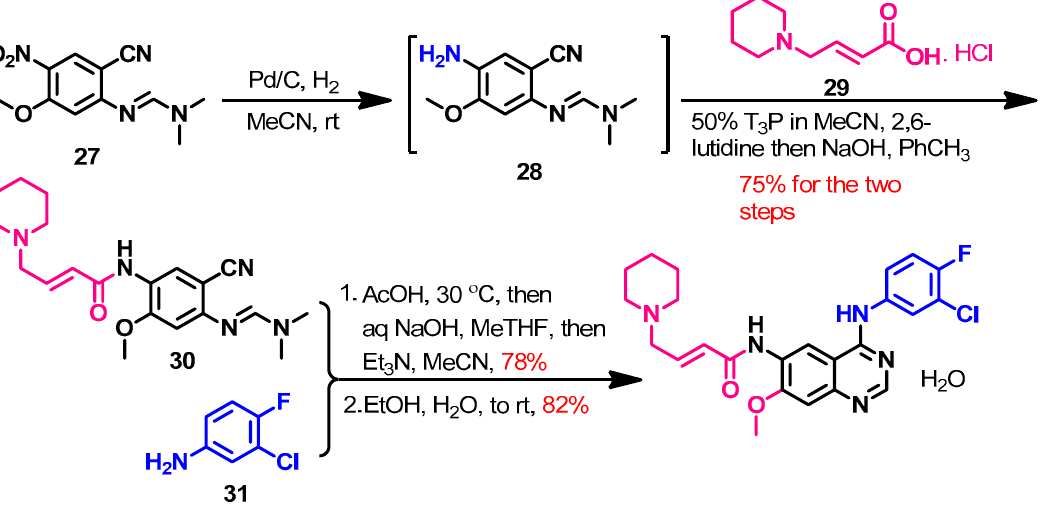
Figure 22. Kinase inhibitory activities of dacomitinib. Crystal Structures and Binding Interactions Dacomitinib exists in two crystal structures in the protein data bank. These crystals include dacomitinib in complex with the wild-type EGFR kinase domain (pdb: 4I23) and T790M EGFR kinase domain (pdb: 4I24) [66]. The binding mode and interactions of dacomitinib into EGFR T790M kinase domain (pdb: 4I24) are visualized in Figure 23. Dacomitinib exhibited one covalent bond with Cys797, one conventional hydrogen bond with Met793, one halogen interaction with Leu788, one pi-donor hydrogen bond with Thr854, and three carbon hydrogen bonds with Gln791 and